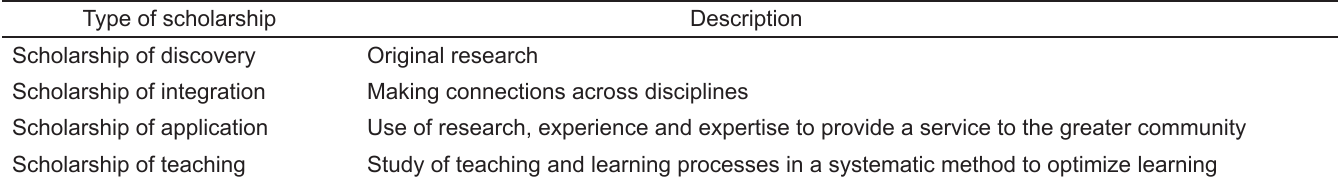
Table. Boyer’s classification of the four types of